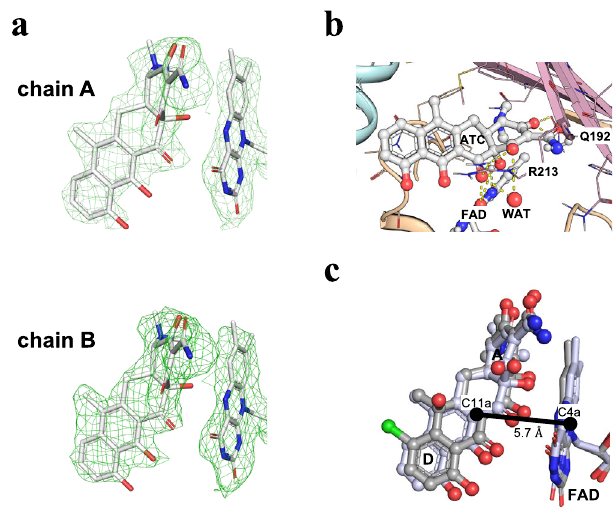
Fig. 4 Anhydrotetracycline binds in a substrate-like orientation in Tet(X6). a Polder maps (Fo-Fc map contoured at 3 σ ) identify the substate- like binding orientation of anhydrotetracycline (aTC) in the two chains of the Tet(X6) crystal structure. The complete Polder map is shown in Supplementary Fig. 6. Asymmetric units of anhydrotetracycline-complexed Tet(X6) X-ray crystal structure is shown in Supplementary Fig. 4. b Key interactions of anhydrotetracyclines with active site residues of Tet(X6). c Aligned crystal structures of Tet(X6)-anhydrotetracycline complex with Tet(X)-chlortetracycline (CTC) complex structure (PDB ID: 2Y6R). Aligned CTC and FAD from Tet(X) structures are shown in grey. The C11a of aTC is at 5.7 Å from C4a of the FAD isoalloxazine